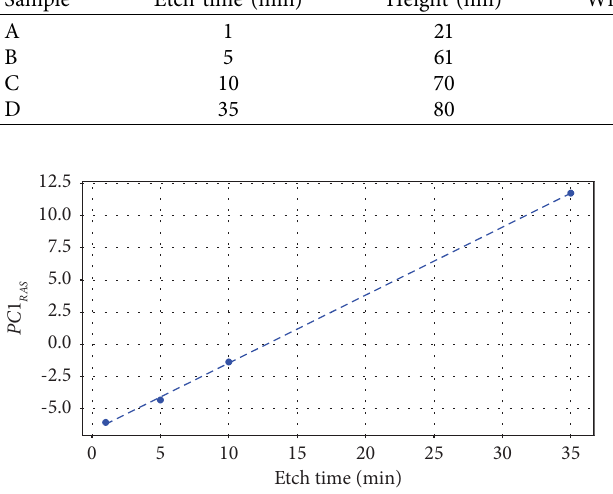
RAS on etch time: both quantities are